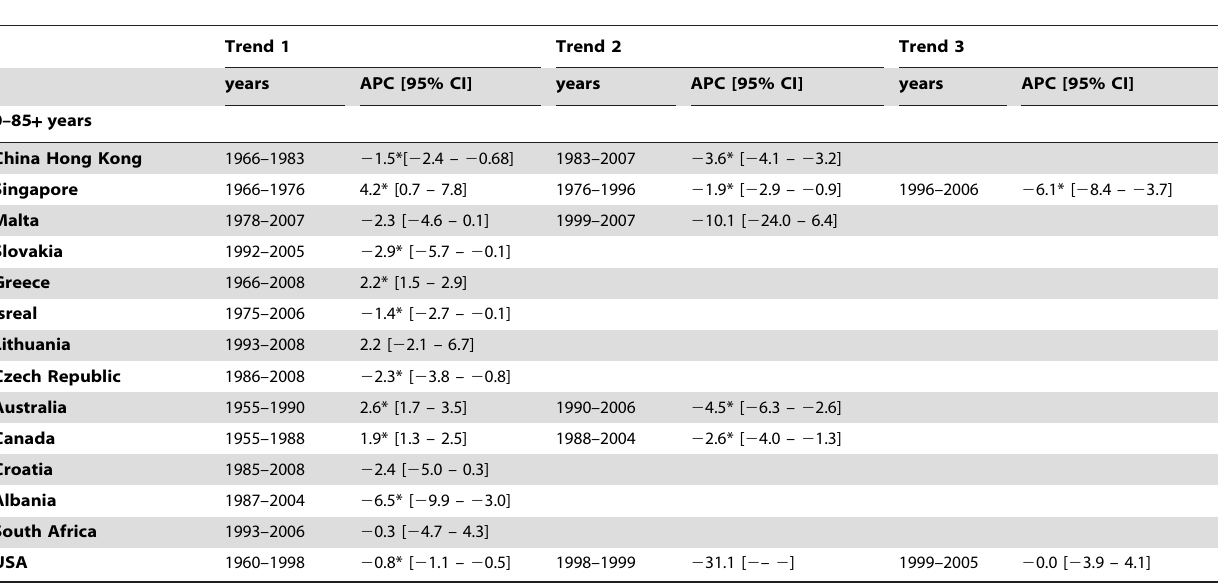
Table 1 . NPC mortality rate trends in all age male population with Joinpoint analyses on the available data of the 14 out of the top 20 mortality rate registries.